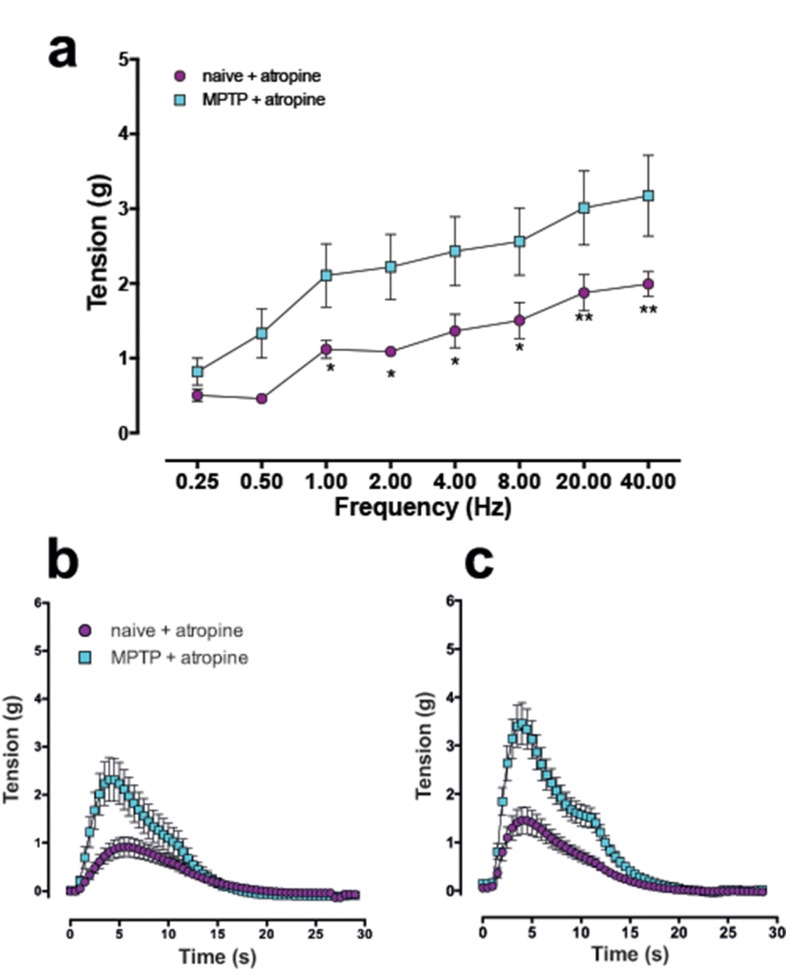
Frequency dependent increase in contractile response of the isolated detrusor strips in response to trains of 20 pulses at frequencies ranging from 0.25 to 40 Hz in the in the presence of 1 μM atropine in normal and the equivalent tissues obtained from MPTP-treated animals (a). Expanded time-course data shows that the first phase of contraction was markedly larger in MPTP strips compared to detrusor strips from normal drug naïve animals at 4 Hz (b) and 40 Hz (c). Each data point represents mean ± sem (n = 4–5) * P<0.05, **P<0.005.